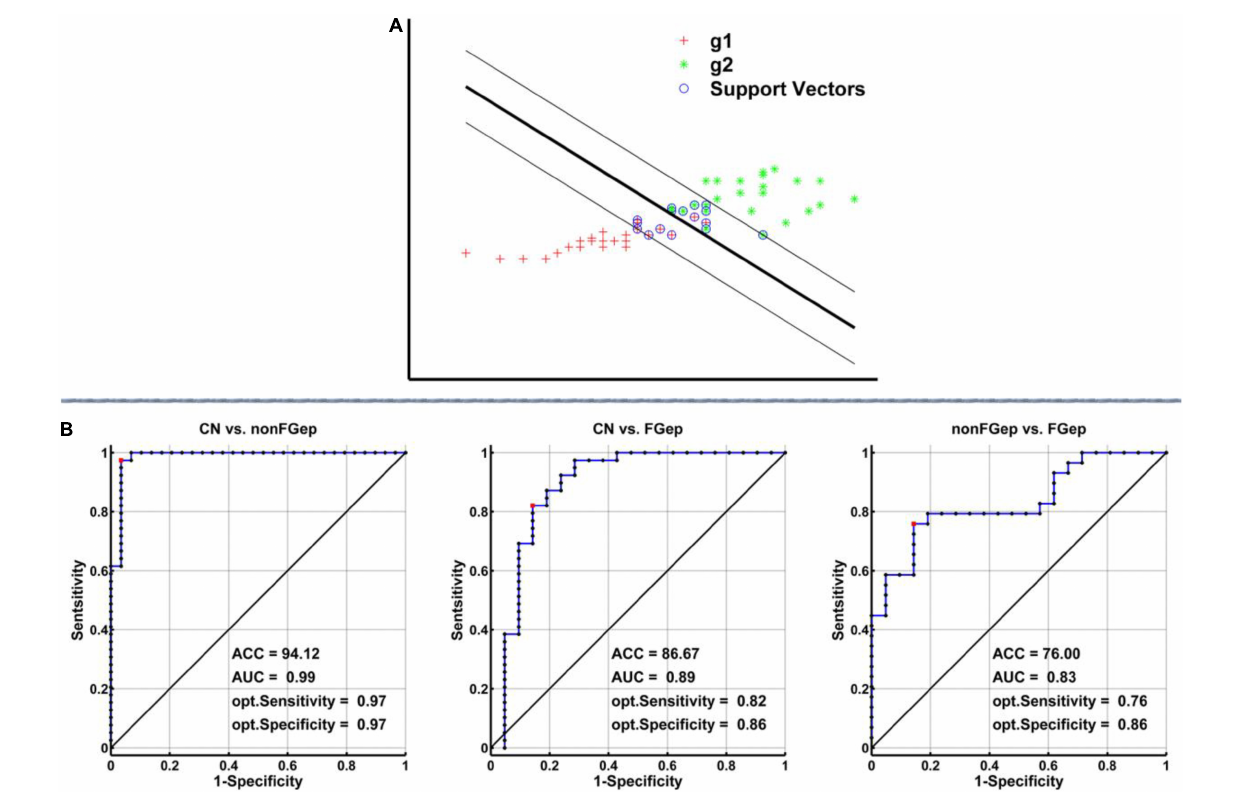
FIGURE 5 | Classification power of the MRI-based “classifier” in distinguishing individuals as non-FGep vs. CN, FGep vs. CN, and non-FGep vs. FGep. (A) The schematic diagram indicated a support vector machine “classifier” based on altered structural (GM) and functional (ReHo and FC) characteristics within the executive control network. (B) ROC curve showing the classification power of the MRI-based “classifier.” The values of ACC, AUC, sensitivity, and specificity are marked in the lower right of the figure. CN, healthy controls; non-FGep, frontal glioma without epilepsy; FGep, frontal glioma with epilepsy; ACC, accuracy; AUC, area under the curve; GM, gray matter; ReHo, regional homogeneity; FC, functional